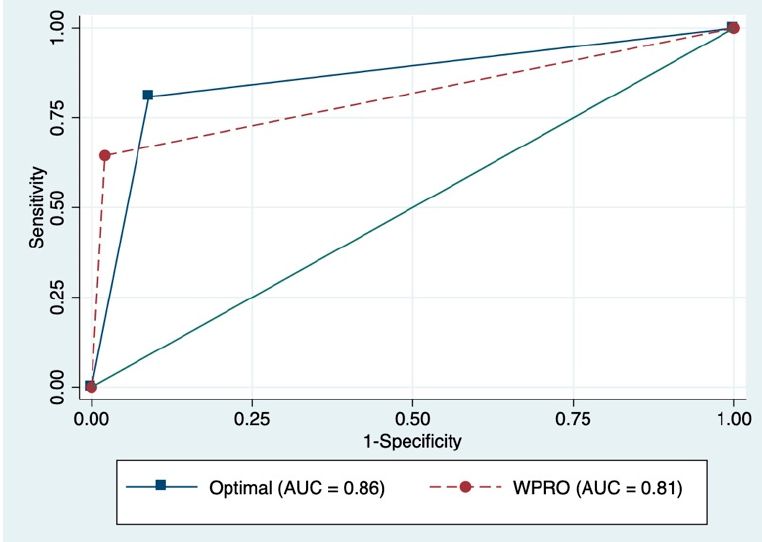
Figure 1. Receiver operator characteristic (ROC) curves and corresponding area under the curve (AUC) among Filipina participants. WPRO, Western Pacific Regional Office.